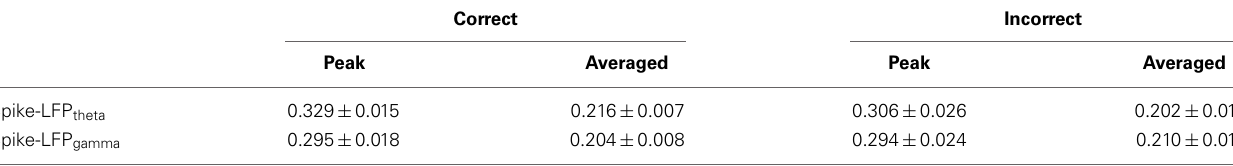
Table 5 | Entropy of neural activity in correct and incorrect trials in the A β group. Correct Incorrect Peak Averaged Peak Averaged Spike entropy 0 . 174 ± 0 . 008 LFP theta entropy LFP gamma entropy 0 . 827 ± 0 . 007